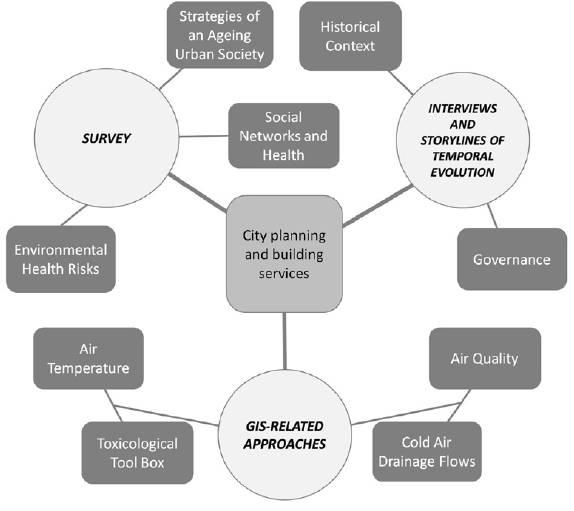
Figure 2. Project organisation related to commonly application ap-